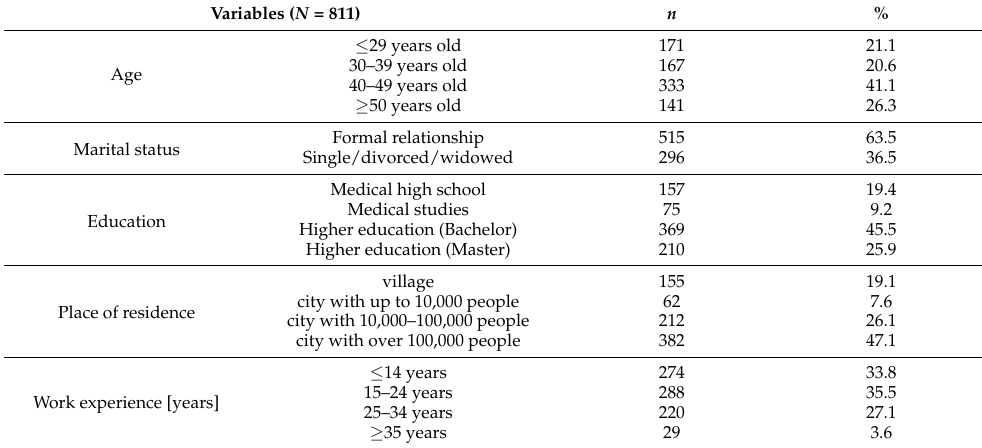
Table 1. Sociodemographic